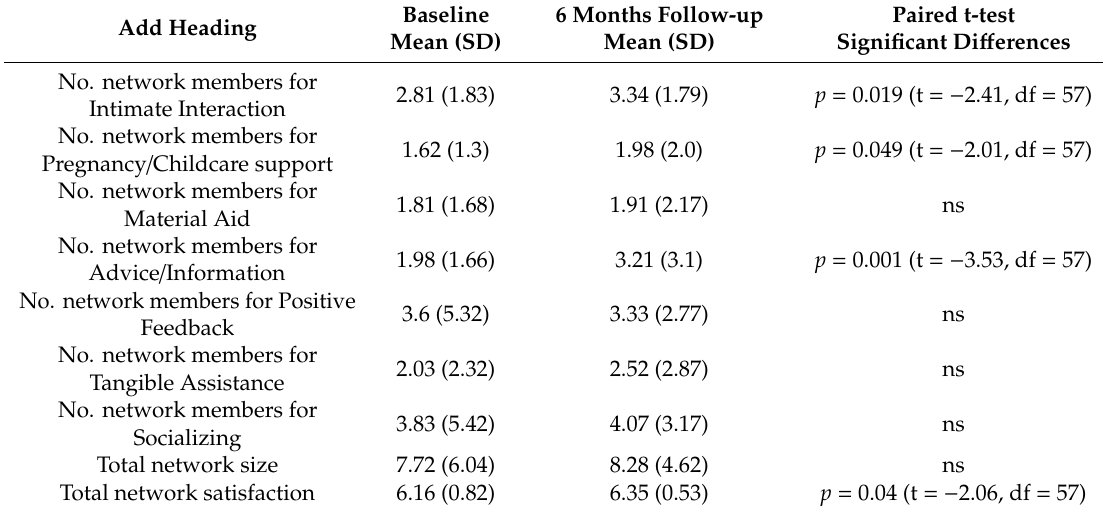
Table 5. Arizona Social Support Interview Schedule (ASSIS): The number of network members for each of the seven areas of support and total network size, and total network satisfaction, at baseline and follow-up, and results of the paired t-test, n =